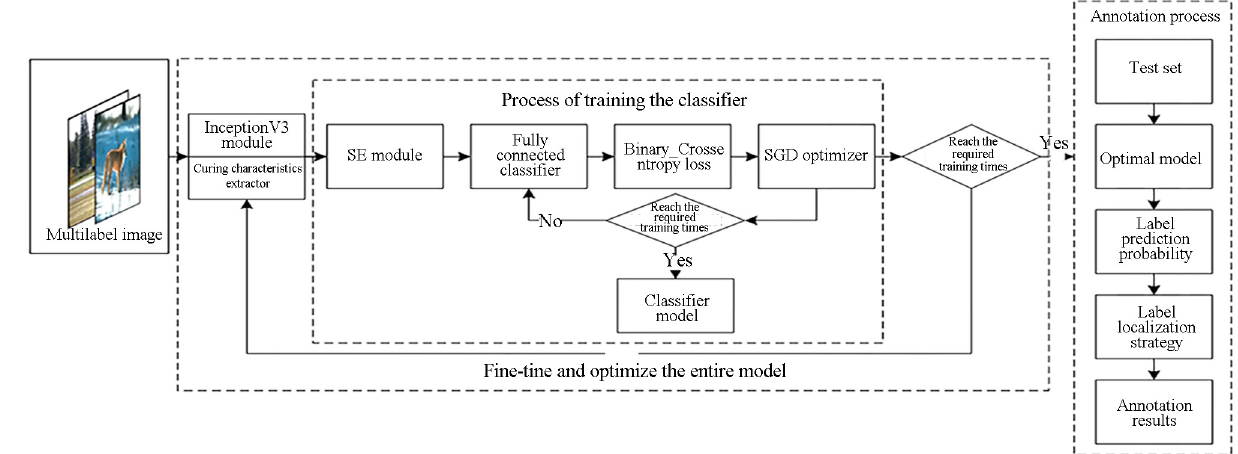
Fig 1. Framework of the multilabel classification